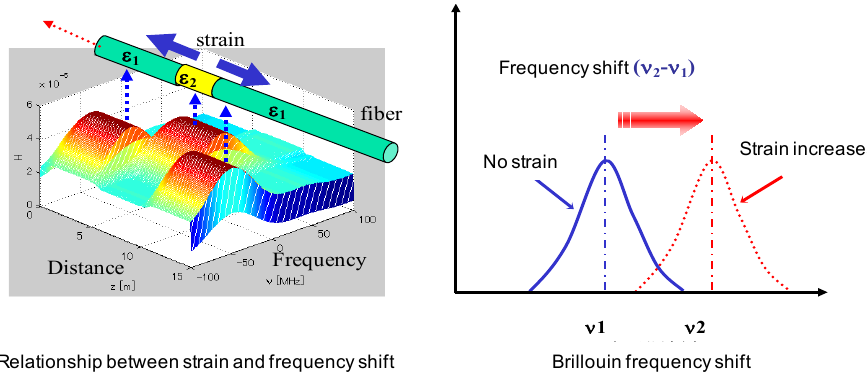
( b ) Figure 4. Schematic diagram of roof fracture of multi-key layer structure ( a ) initial weighting pro- cess ( b ) period weighting process.